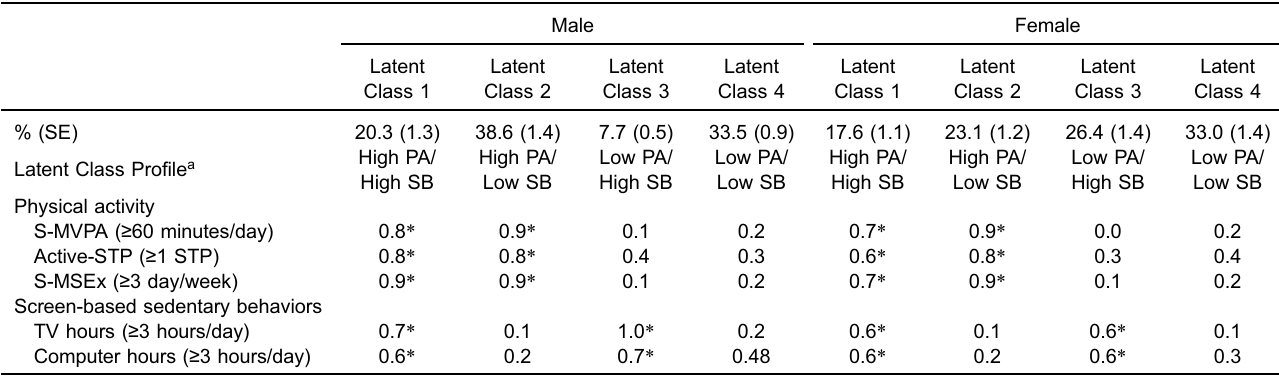
Table 3. The estimated item-response probabilities of PA and screen-based SB across the latent subgroups Male Female